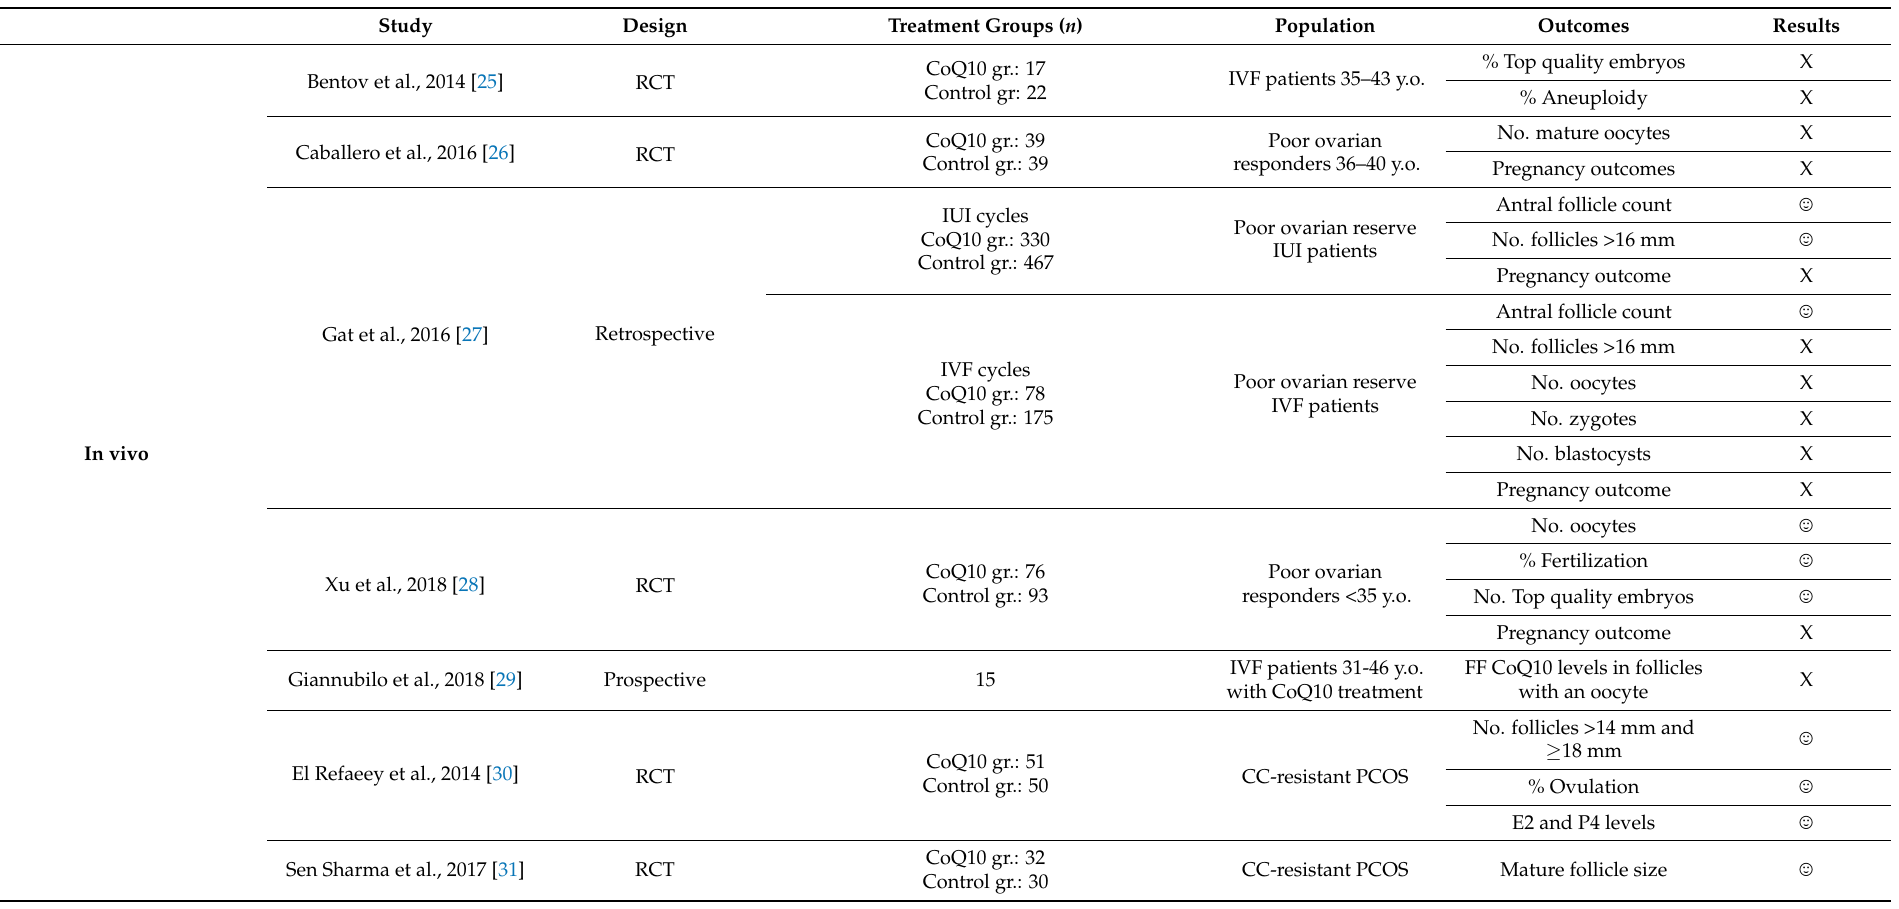
Table 1. Summary of the main human studies evaluating CoQ10 supplementation both in vivo and in